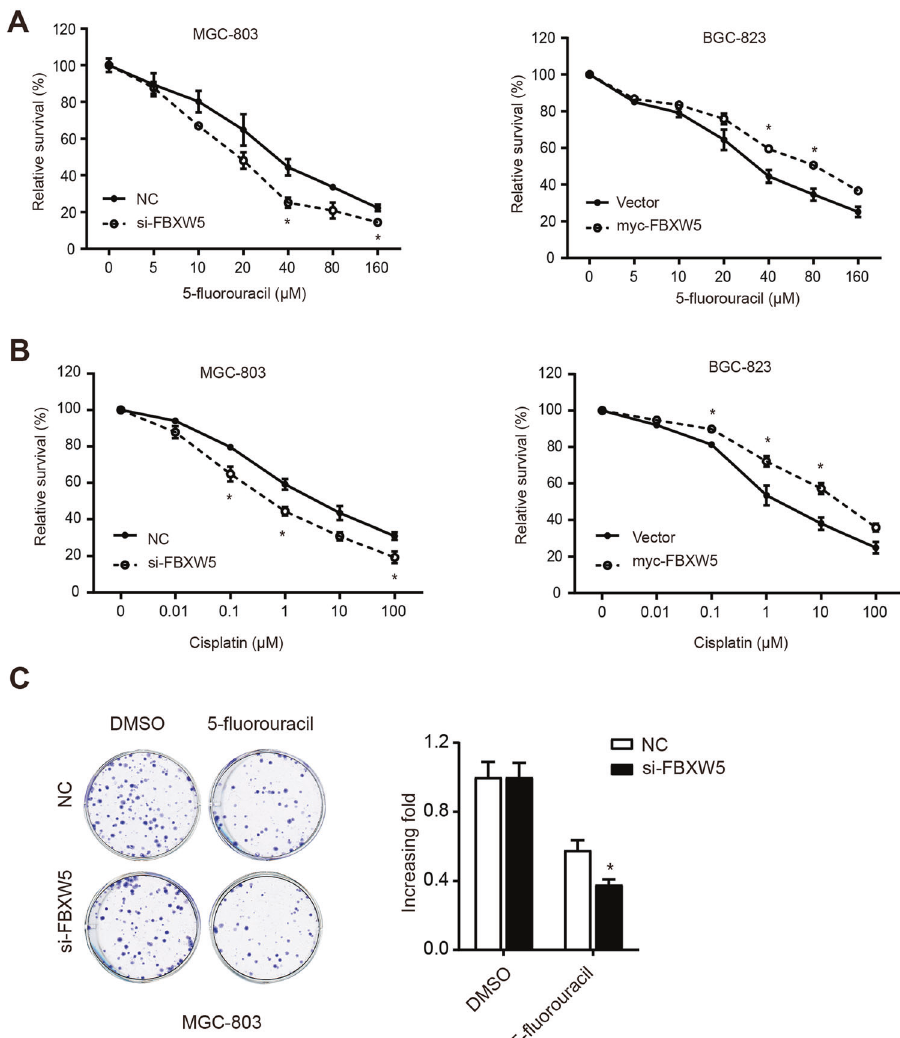
Fig. 3 FBXW5 promotes drug resistance in GC cells. A , B 5-Fluorouracil (5-FU) or cisplatin was added to the transfected cells for the chemo- sensitivity experiments. Thereafter, cellular viabilities were determined using CCK8 analysis. C Treatment of transfected MGC-803 with 40 μ M 5-FU; colony formation assays were carried out. * P < 0.05, ** P < 0.01. The experiments were repeated three times with the most signi fi cant results